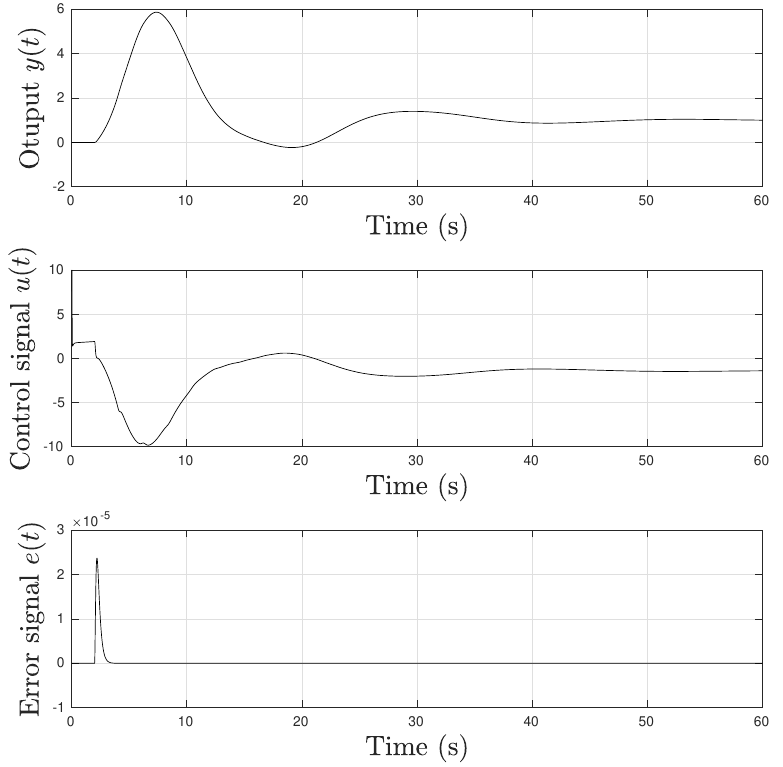
Figure 6. Time evolution of the closed-loop system with one unstable pole for τ =